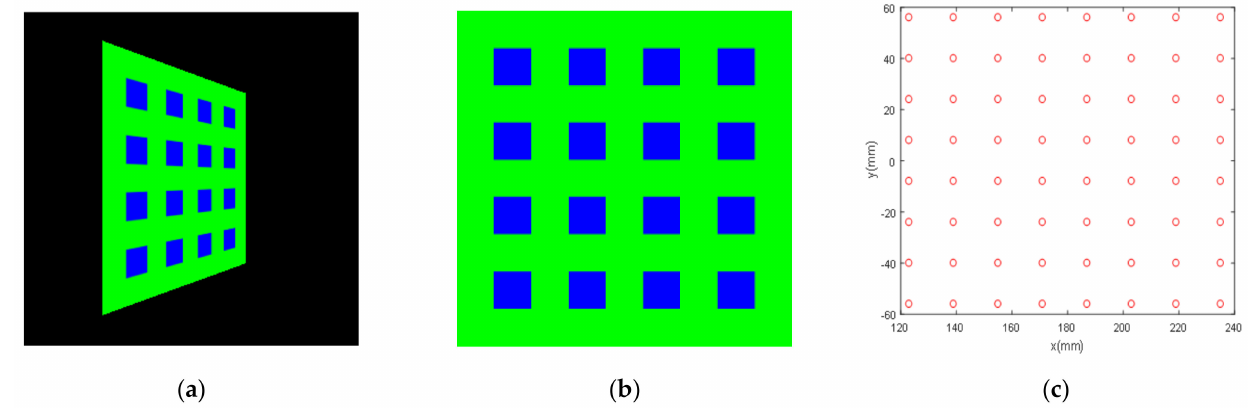
Figure 5. Examples of WAI sampling via structured light projection: ( a ) structured light pattern on the display element of the projector; ( b ) the virtual image formed on the water surface via structured light projection when the WAI is flat; ( c ) sampling point distribution of the WAI for flat water surface. The structured light pattern of blue–green stripes projected by the projector is reflected